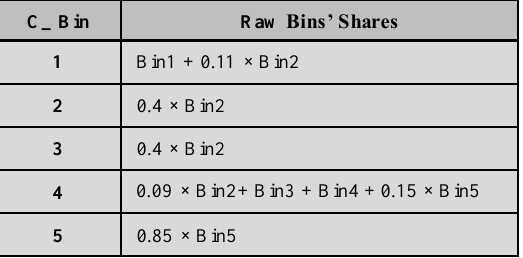
Figure 5. Calibration table of the fine TDC. It describes the shares of the raw bins in the calibrated bins.